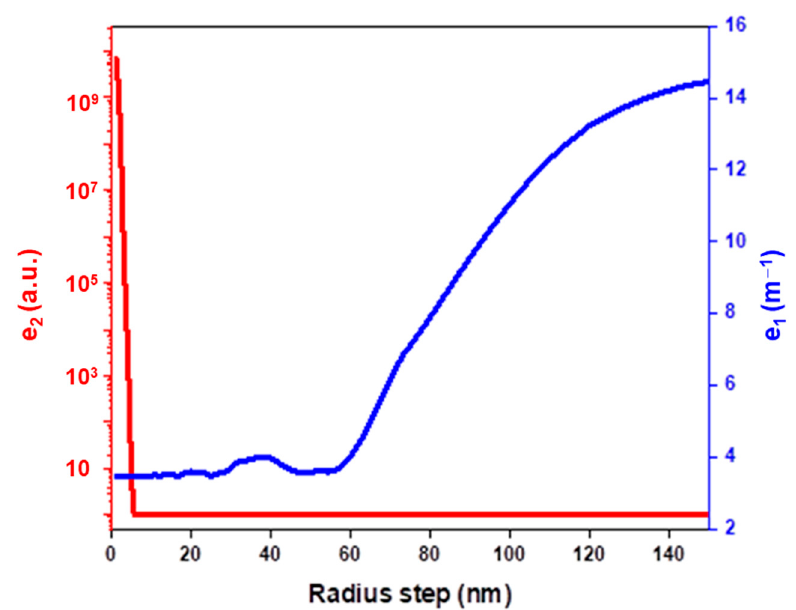
Figure 1. Evolution of e 1 and e 2 with radius step.